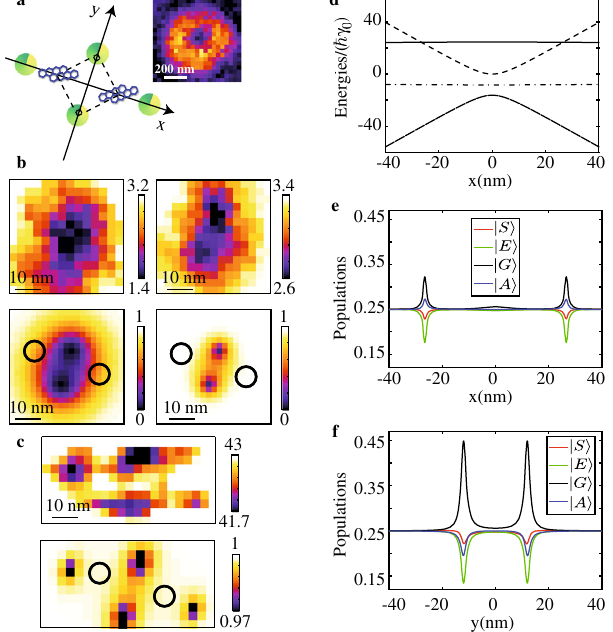
Fig. 5 Optical nanoscopy of molecules undergoing coherent optical dipole – dipole coupling. a Con fi guration of the molecules in the focal plane ( x , y ). The green disks mark the four positions of the doughnut beam center leading to fl uorescence dips. For the two positions marked along the y-axis, the phase difference between the laser fi elds felt by the two molecules is π / 2. Inset: Fluorescence image recorded at weak saturations. b , c Experimental (top frames) and simulated ESSat (bottom frames) images of a pair of coupled molecules excited with a laser tuned on the two-photon transition, with increasing doughnut-peak intensities: 125 W cm − 2 , 500 W cm − 2 ( b ), 5.4 × 10 3 W cm − 2 ( c ). The simulated ESSat images are computed with Δ = 0, V = − 22 γ 0 , γ 12 = 0.5 γ 0 and intensities of 175 W cm − 2 , 700 W cm − 2 ( b ), 7 × 10 3 W cm − 2 ( c ). The in-plane positions of the emitters, separated by (22 ± 5) nm, are marked with a circle. d Evolution of the four eigenenergies of H as the excitation beam is swept along the x -axis. e Evolution of the stationary populations of | G 〉 ,| A 〉 , | S 〉 and | E 〉 along the x -axis. Each eigenstate experiences a position-dependent light shift and the fl uorescence signal drops at the degeneracy points. Such coincidences are accompanied by a population increase for the | G 〉 and | A 〉 . f Evolution of the stationary populations of | G 〉 , | A 〉 , | S 〉 and | E 〉 as the laser spot is swept along the y-axis. The peaks of | G 〉 population occur at the two positions where Ω 2 ¼ Ω 1 e ± i π 2